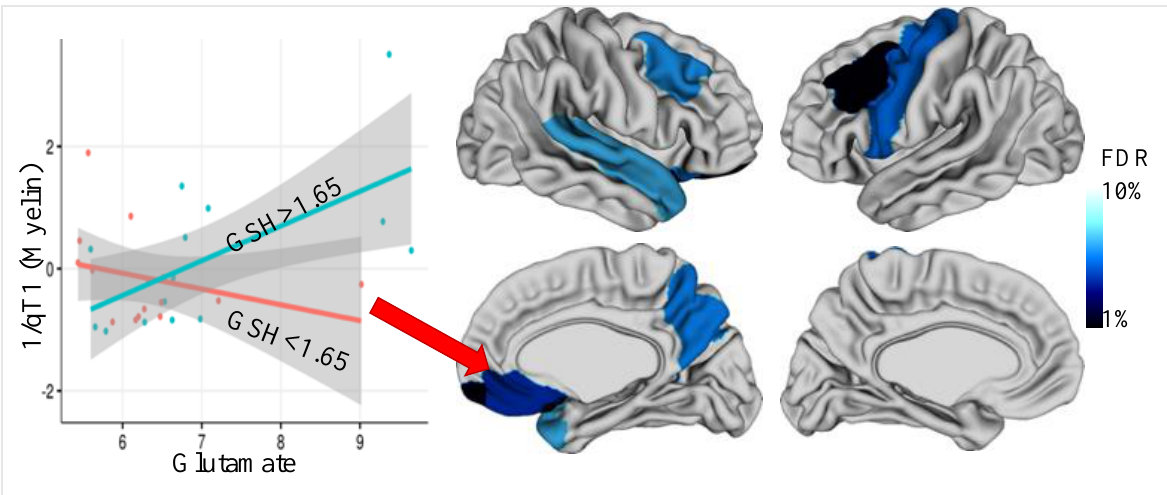
Figure 1. Permissive role of GSH on glutamate-related demyelination. Intracortical myelin (qT1) was mapped at the mid-cortical surface (50% depth between the white matter on pial surfaces) using the CIVET pipeline (https://github.com/aces/CIVET (accessed on 24 October 2021)) with T1-weighted images. Median qT1 values were gathered over cortical regions defined by the Desikan–Killiany Atlas (DKT40). In First Episode Psychosis ( n = 30), glutamate relates to reduced prefrontal, orbitofrontal, and superior temporal intracortical myelin (1/qT1) only when GSH levels are also lower (red slope) in the dorsal ACC [MRS voxel not shown]—results were significant in 8 cortical regions after FDR correction (10%). Scatterplot shows the right lateral orbitofrontal cortex [contiguous with the medial surface that is shown on display], indicating significant glutamate-by-GSH interaction effect (t 24 = 5.59, p = 9.52 × 10 −6 ) on qT1, accounting for age and sex as covariates in multiple linear regression. Mean age 23.13 (SD 5.30), with 24/6 male/female subjects.